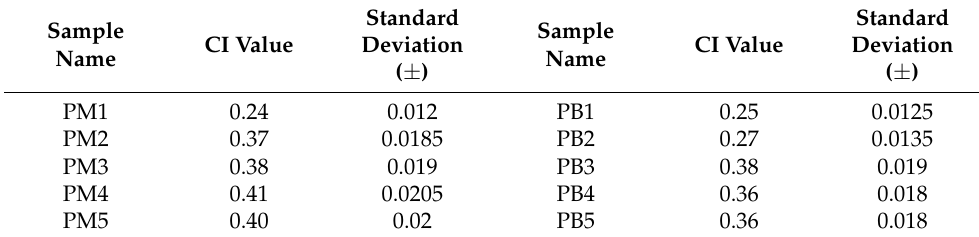
Figure 4. Comparison of the spectra of pure polypropylene (PP) and highest maleic anhydride (MAH) grafted PP obtained by Fourier Transform Infrared Spectroscopy (FTIR). Table 3. Carbonyl Index (CI) values of all grafted samples.